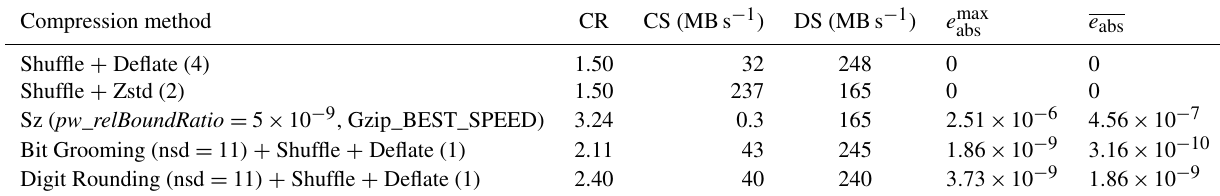
Table 11. Compression results for the pixel_area variable in the representative SWOT L2 pixel cloud product.